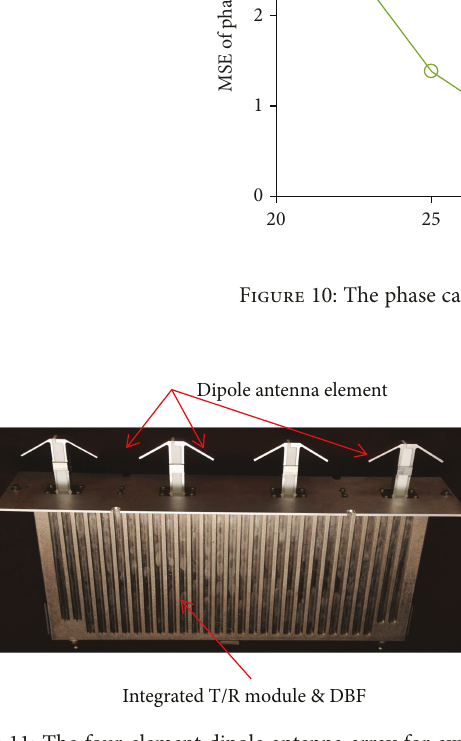
Figure 11: The four-element dipole antenna array for experiment